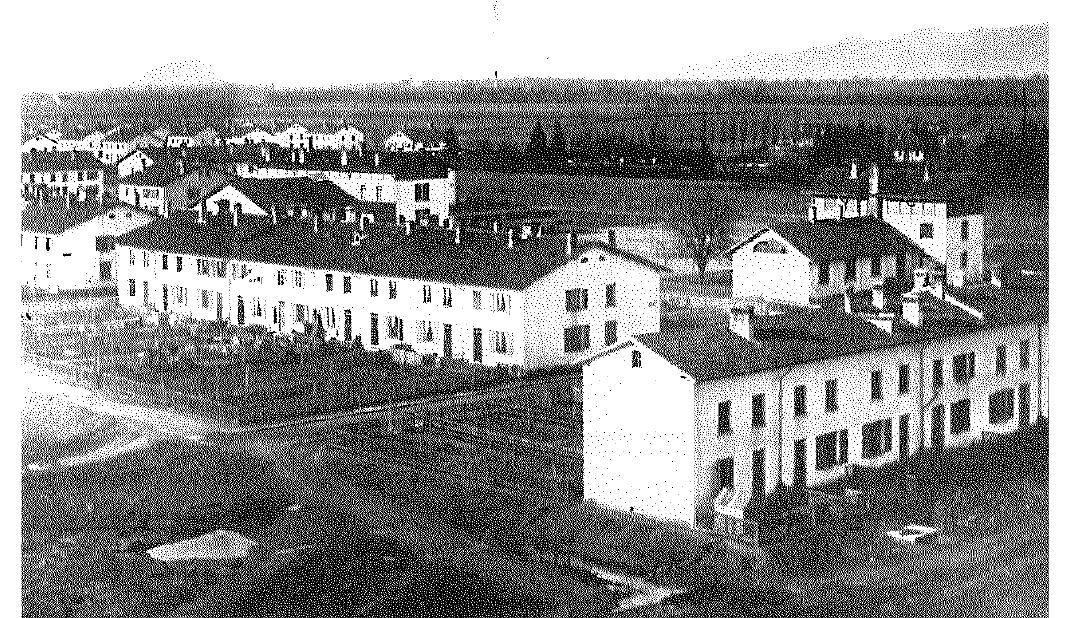
Figure 5. View of the first development phase of Cité Ouvrière in Mulhouse, ca. 1857. Source: Jonas (2003, p.